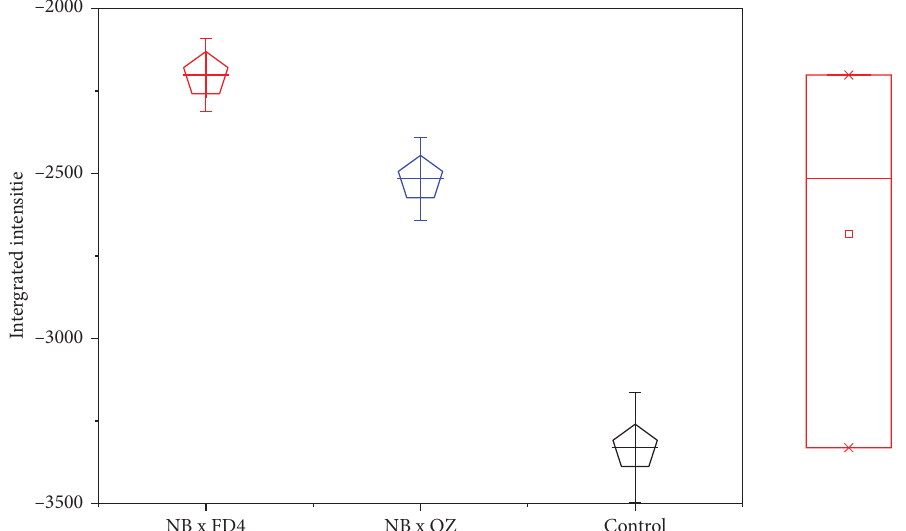
Figure 4: Overall integrated intensities of fig seeds IR spectrum as affected by pollination. FD4 :Frond d’Oued N ° 4; OZ :